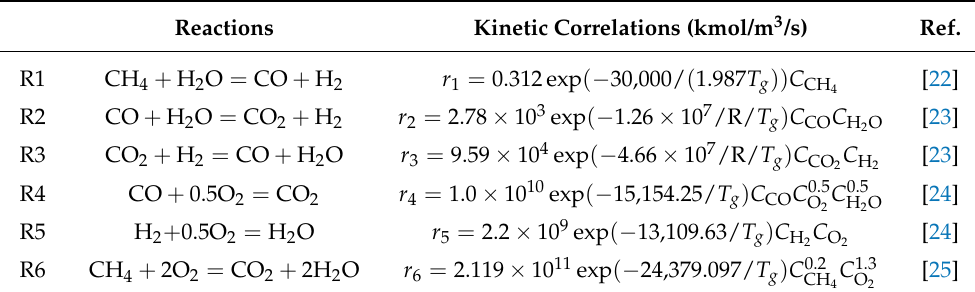
Table 3. Dominant reactions and corresponding kinetic correlations.